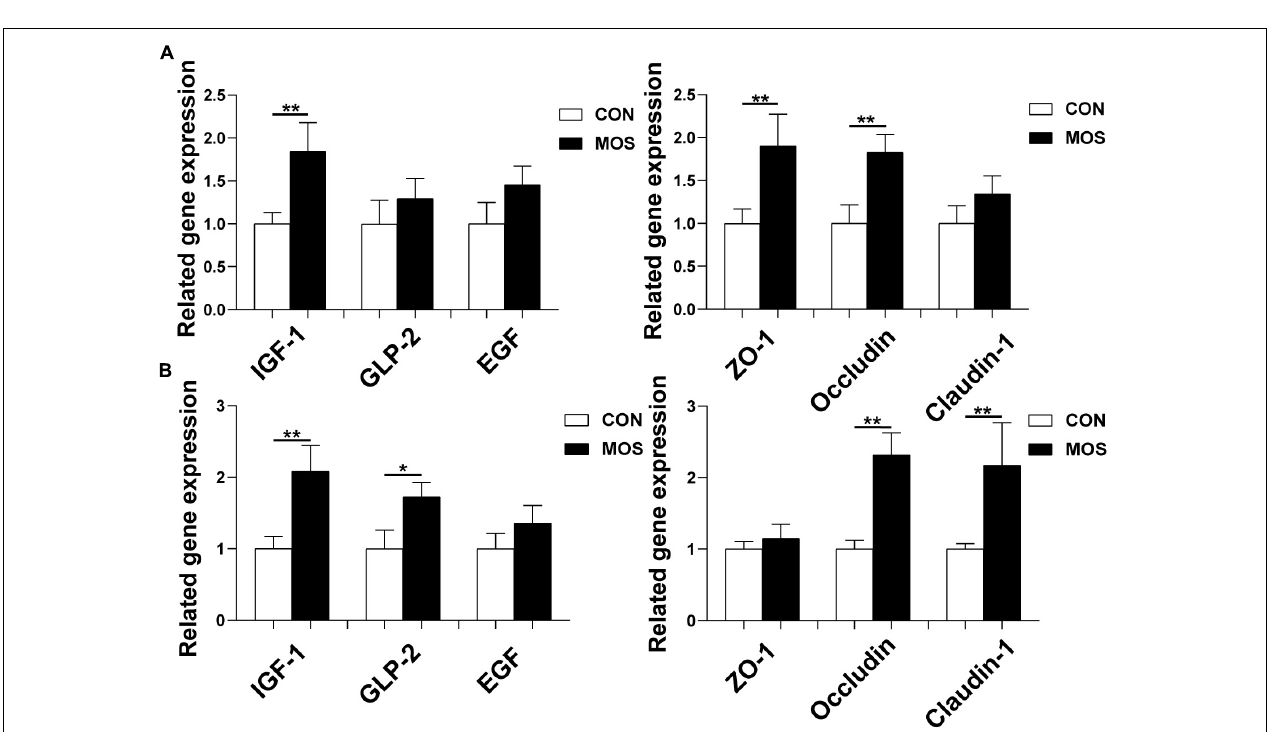
FIGURE 11 | Effect of MOS on expression levels of genes related to intestinal barrier functions. Ileum (A) and cecum (B) digesta samples were collected from pigs fed with the basal diet (CON) or a basal diet supplemented with 3 g/kg MOS (MOS) ( n = 8). *0.05 < p < 0.1, ** p <